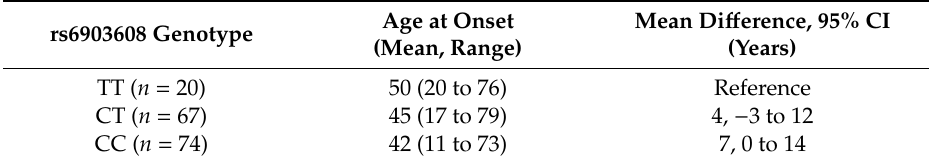
Table 5. Age at onset according to the rs6903608